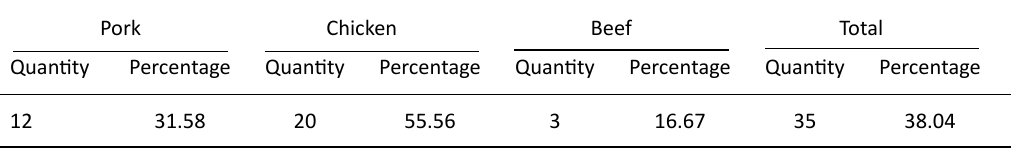
Table 3. Antimicrobial susceptibility of Salmonella spp. in raw meat